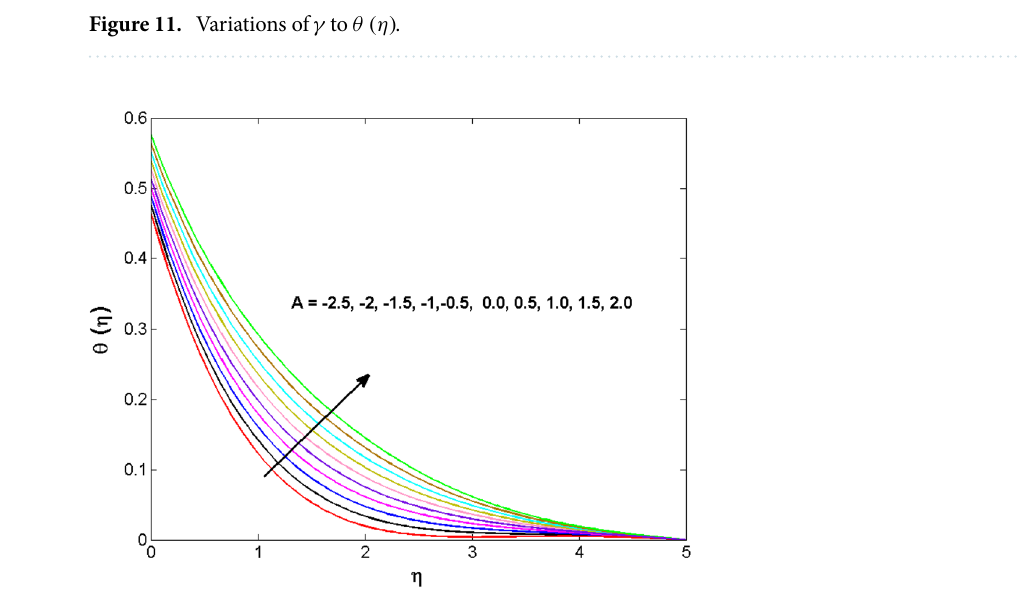
Figure 12. Variations of A to θ (η)